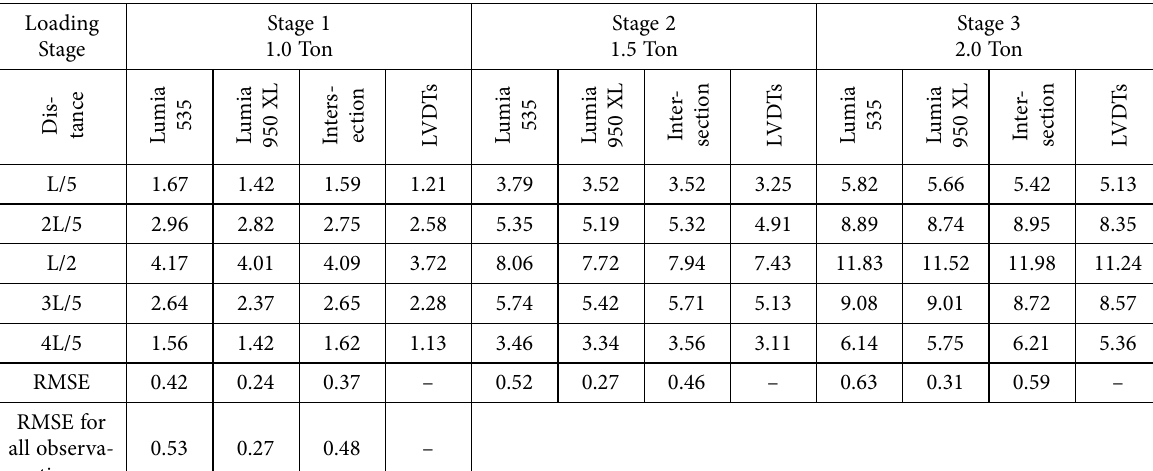
Table 3. Values of vertical deflections and RMSEs (in